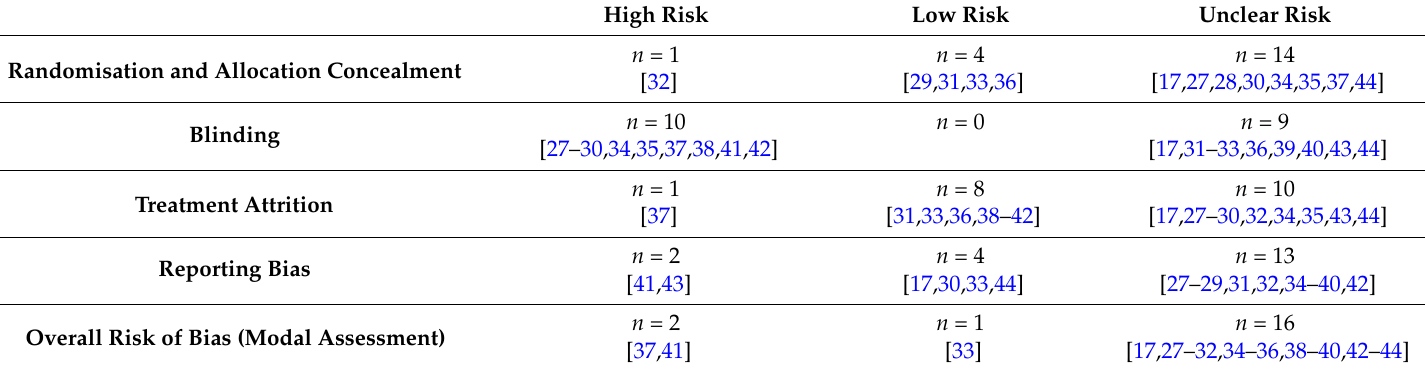
Table 3. A synthesis of the quality appraisal of the nineteen included